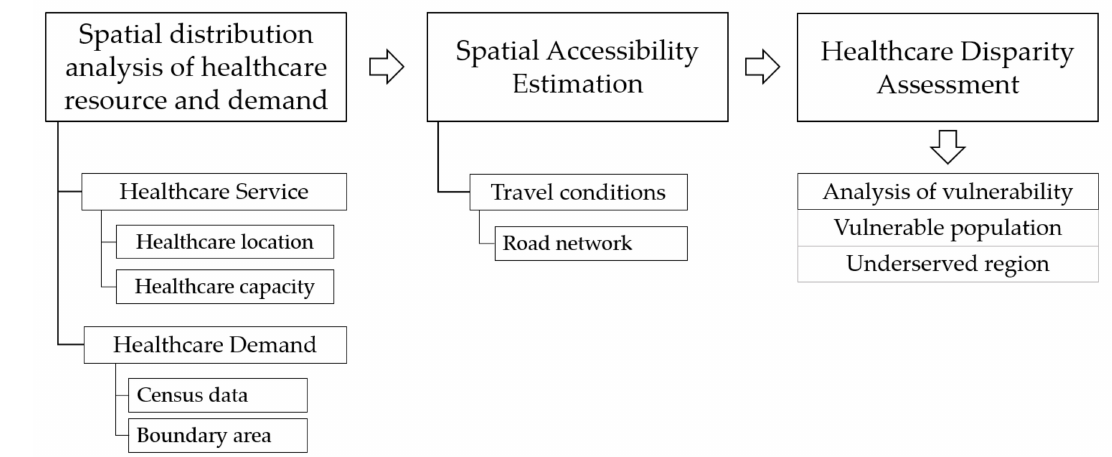
Figure 1. Methodology flowchart of the